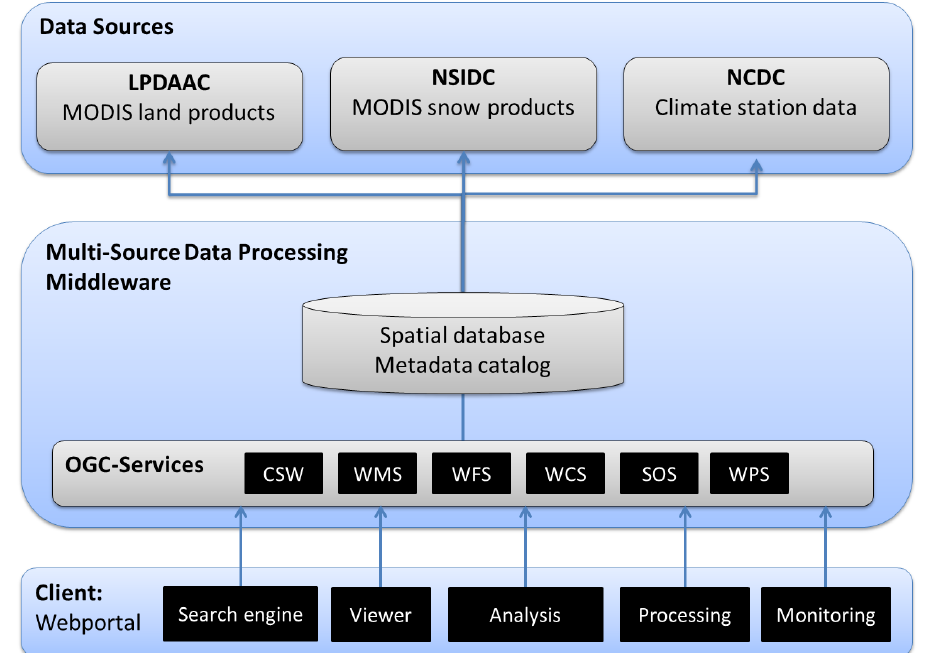
Figure 3. System overview for the framework developed within the Siberian Earth System Science Cluster (SIB-ESS-C). OGC, Open Geospatial Consortium; CSW, Catalogue Service for Web; WMS, Web Map Service; WFS, Web Feature Service; WCS, Web Coverage Service; SOS, Sensor Observation Service; WPS, Web Processing